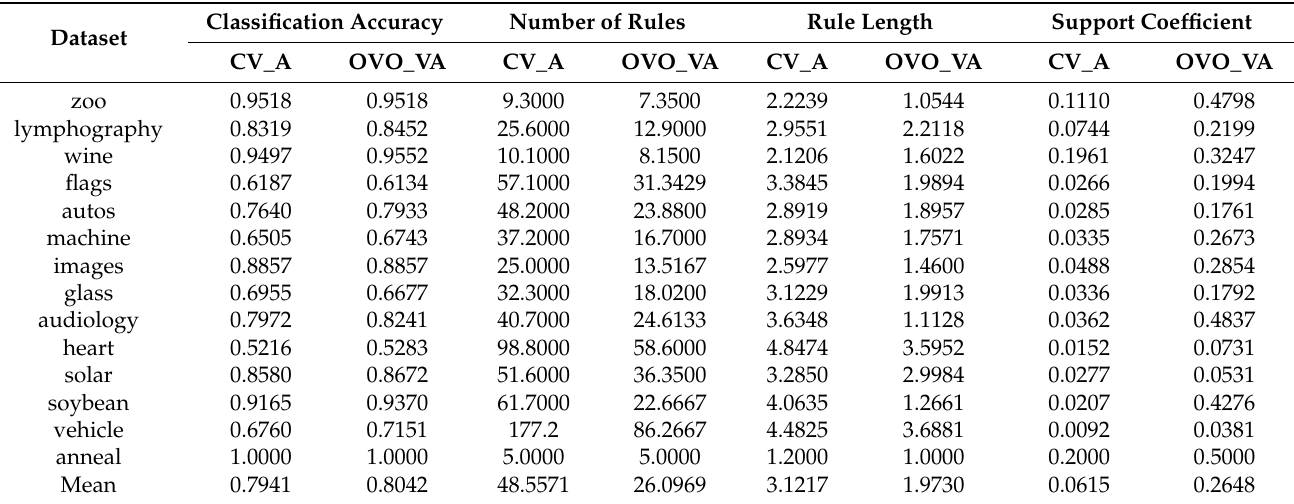
Table 6. Classification accuracy obtained by the method based on all features.